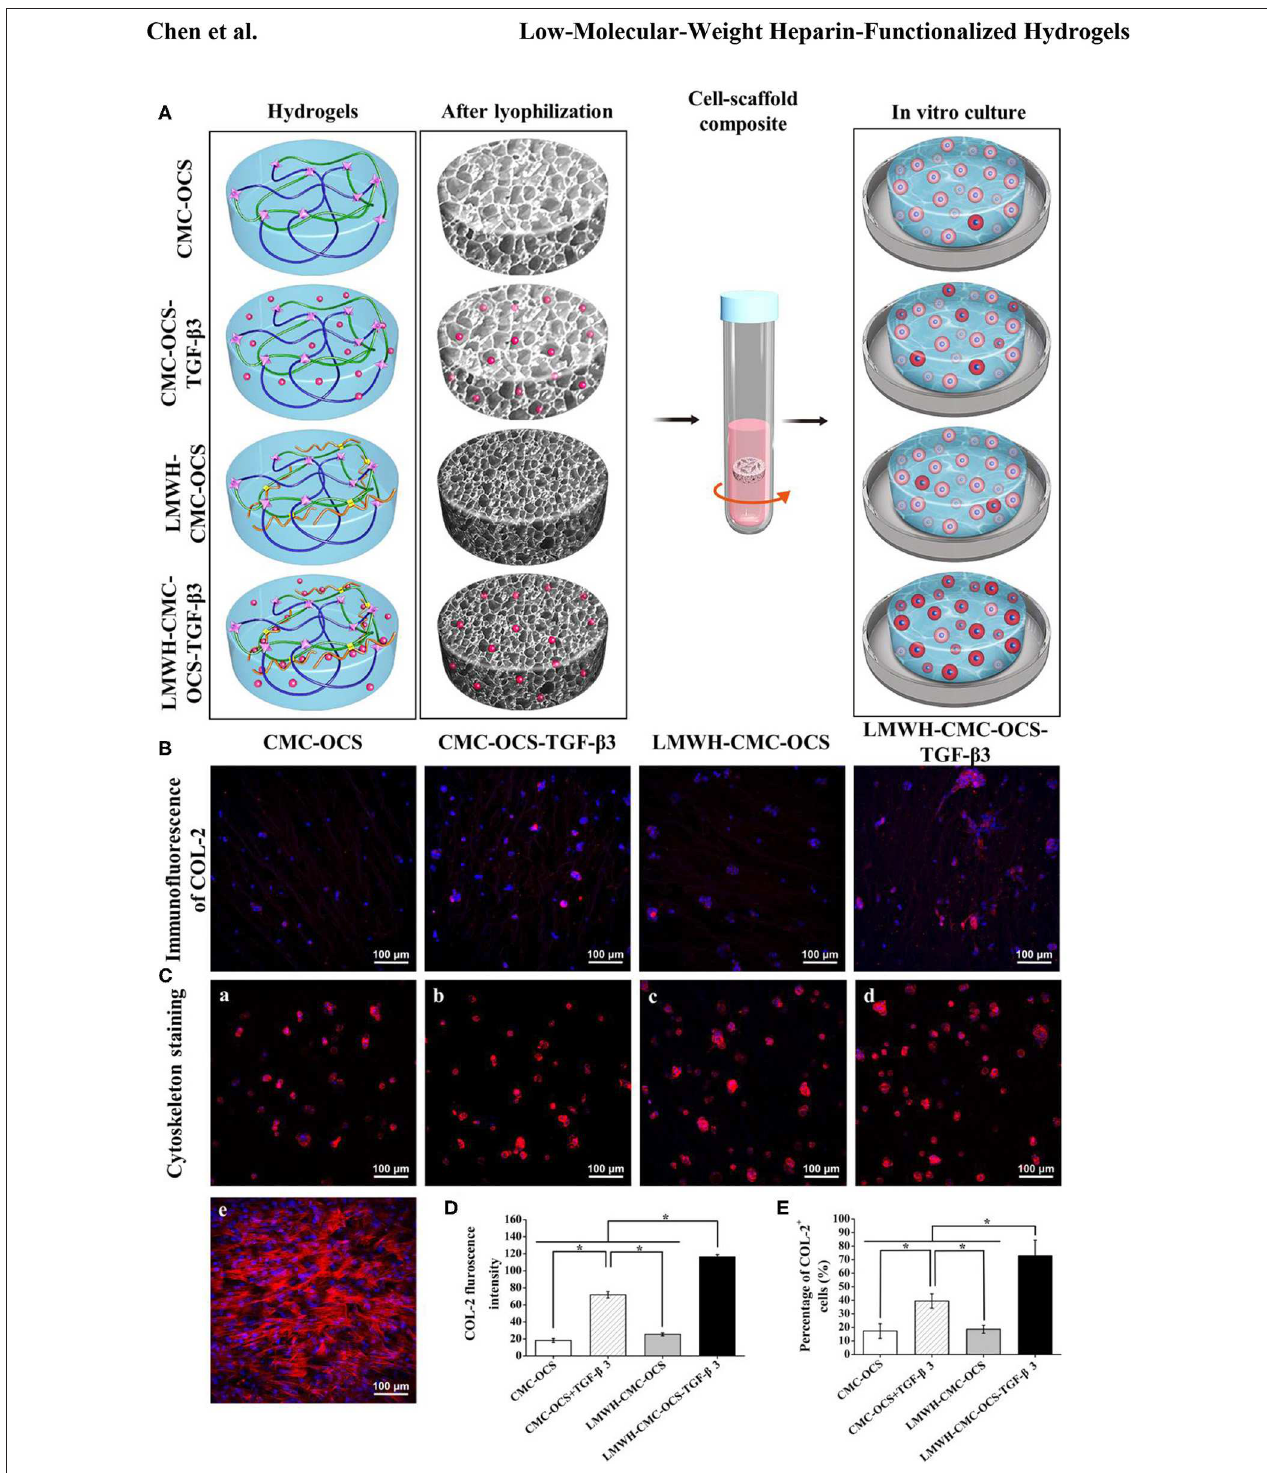
FIGURE 9 | (A) Diagrams of four hydrogels before and after freeze-drying, and seeding with PB-MSCs for in vitro culture. The redder the cytoplasm represented the higher the degree of chondrogenic differentiation of PB-MSCs in hydrogels. (B) Immunoflurorescent staining visualized the production of COL-2 in the PB-MSCs-hydrogel composites after 14 days of in vitro culture. (C) Cytoskeleton staining revealing morphology of PB-MSCs on hydrogels (a–d) and in culture dish (e) after 7 days of culture. (Red, cytoskeleton; blue, nuclei). (D) LMWH-CMC-OCS-TGF- β 3 group showed the highest fluorescence intensity of COL-2 ( n = 3, * P < 0.05) and (E) the highest percentage of COL-2 positive cells ( n = 5, * P < 0.05) among the four groups.